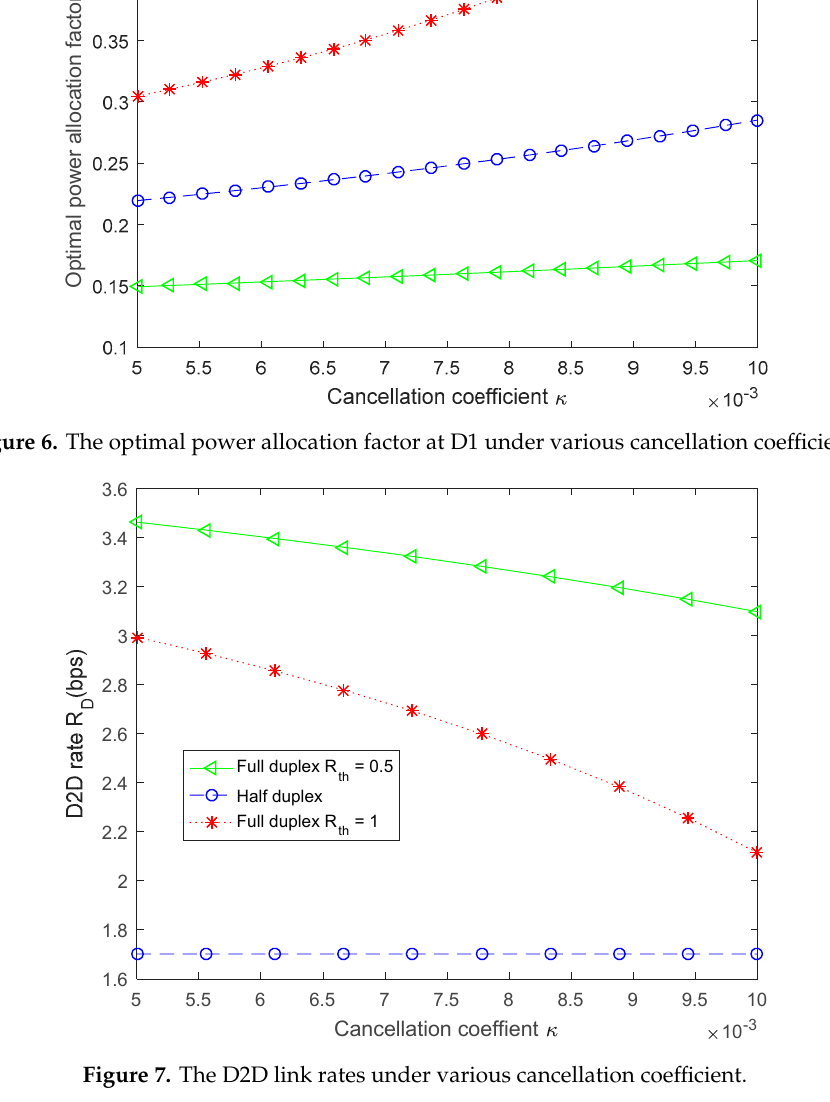
Figure 7. The D2D link rates under various cancellation coefficient.